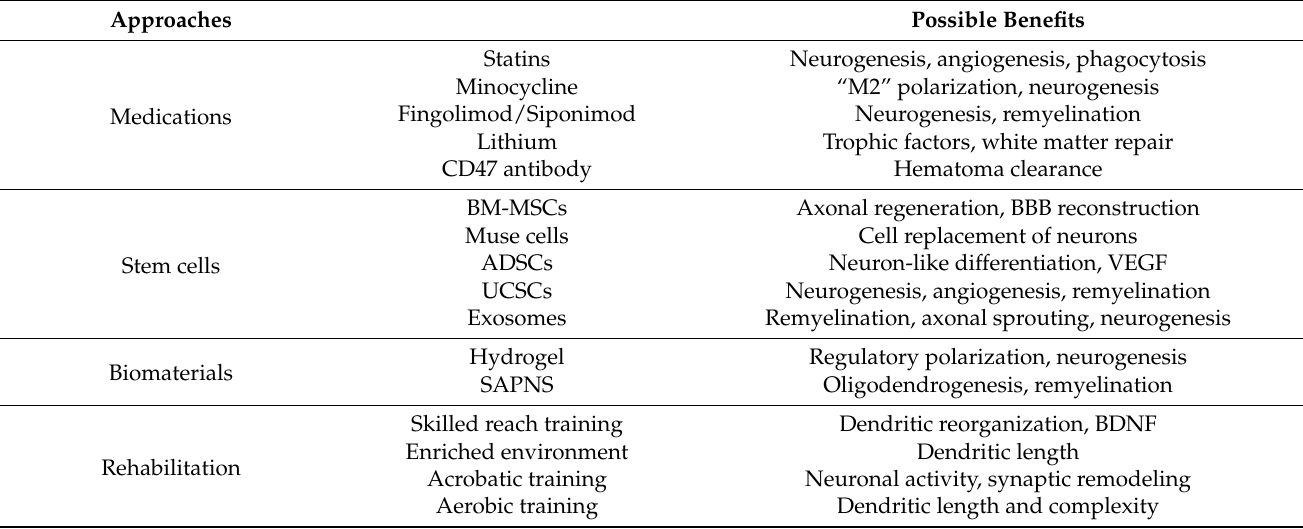
Table 1. Potential strategies to promote tissue regeneration after intracerebral hemorrhage.